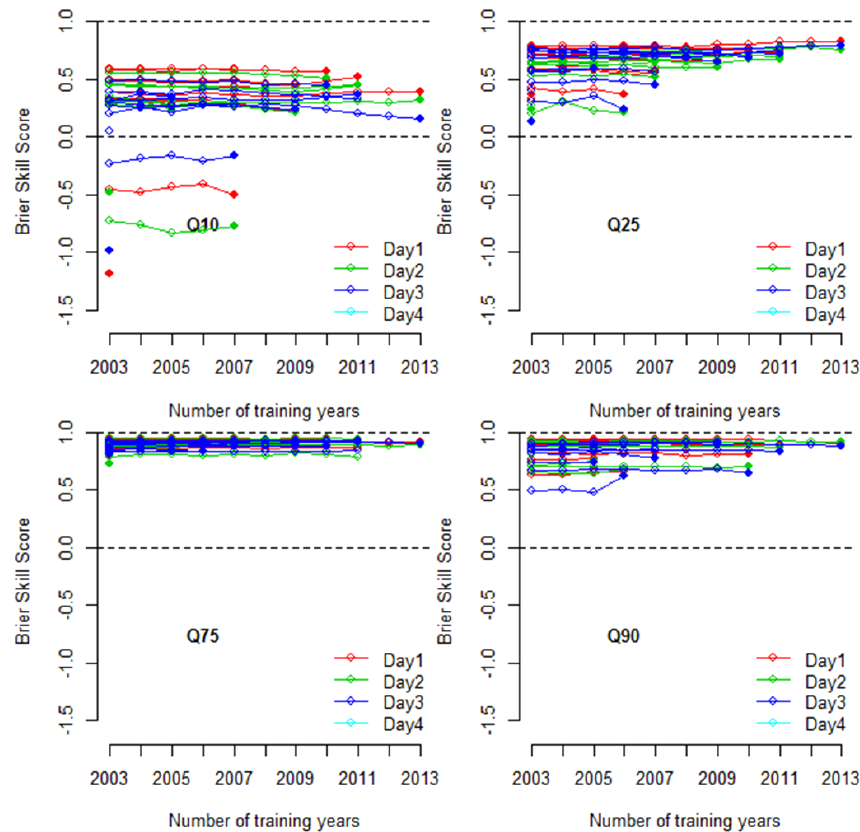
Figure 19. Brier skill score for various forecast years and various sizes of the training data set across different lead times (colors) and event thresholds (plots) for Henry, IL (HNYI2). The filled-in end point of each line indicates the BSS for the forecast year on the x axis with 1 year in the training data set. Each point to the left stands for 1 additional training year for that same forecast